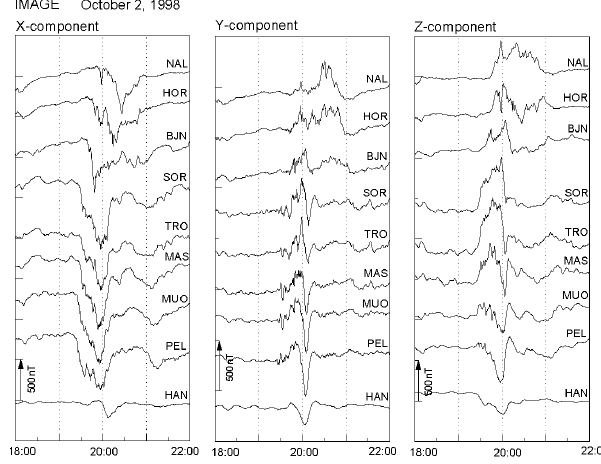
Fig. 2. The temporal behavior of the X , Y , and Z components of the Figure 2 . The temporal behavior of the X , Y , and Z components of the magnetic field variations on 2 October 1998. Data from the IMAGE magnetometers. magnetic field variations on 2 October 1998. Data from the IMAGE